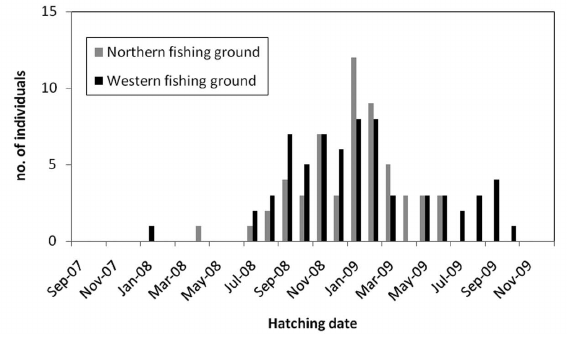
Fig. 6. – Hatching date histogram, resulting from back-calculation according to capture data and estimated age of the 122 successfully aged Eledone cirrhosa